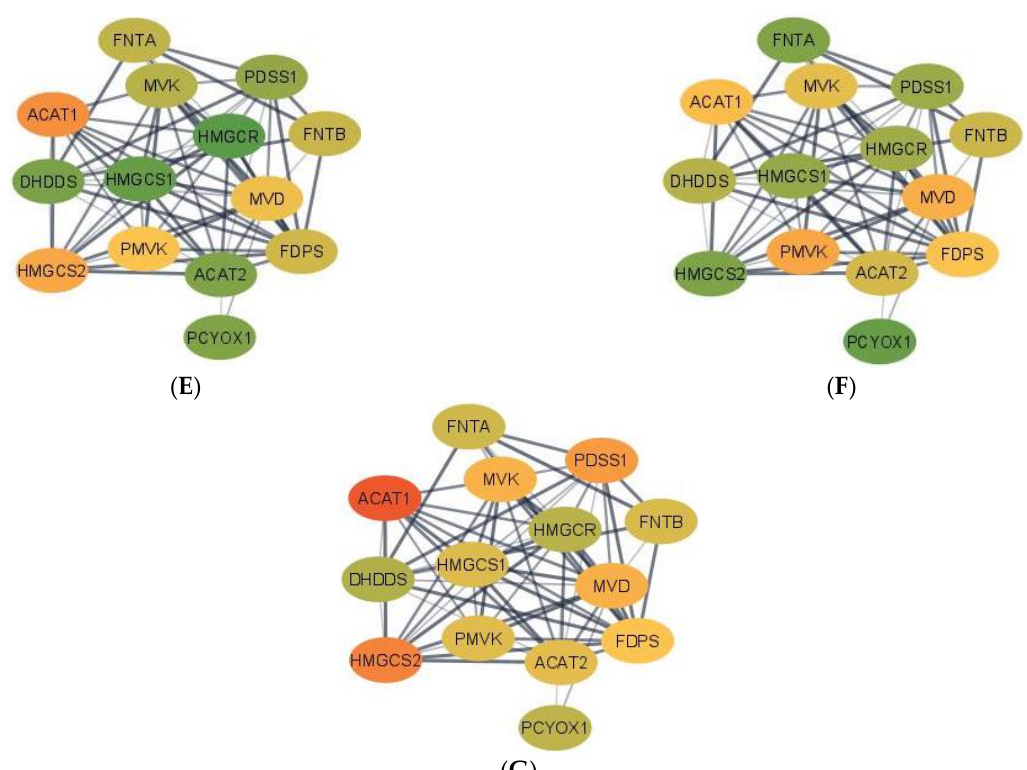
Figure 1. Gene networks for the terpenoid backbone biosynthesis pathway in the hippocampus developed using Cytoscape and the STRING database. Nodes represent genes and edges represent database connections. The node color ranges from red that signifies a − 2.0 log2 (fold change), yellow indicates no fold change, and green indicates a 2.0 log2 (fold change), with colors in between indicating a spectrum. Changes correspond to seven pig groups compared to the baseline Control nursed males. The seven pig groups are: ( A ) — Control nursed females, ( B ) — MIA nursed females, ( C ) — Control weaned females, ( D ) — MIA weaned females, ( E ) — MIA nursed males, ( F ) — Control weaned males, and ( G ) — MIA weaned males compared to Control nursed males.